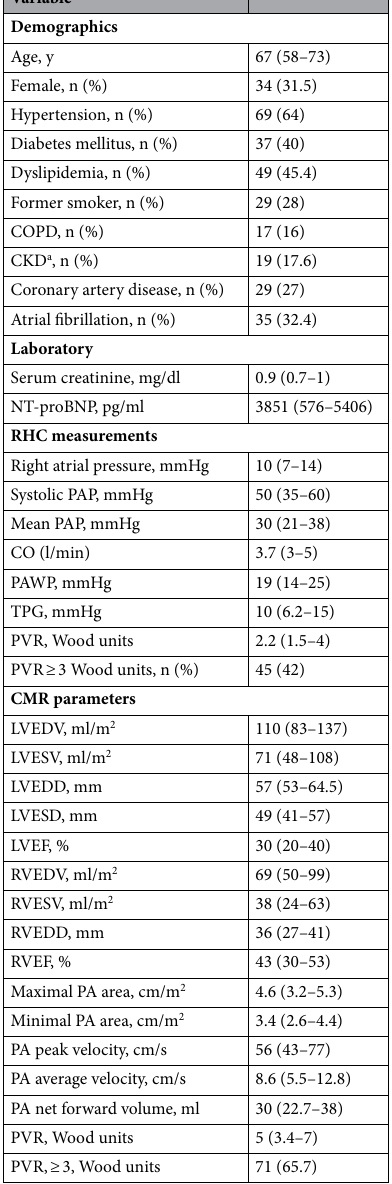
Table 1. Clinical, right heart catheterization and cardiovascular magnetic resonance variables. Data are given as n (%), or median (interquartile range). CMR cardiovascular magnetic resonance, CKD chronic kidney disease, CO cardiac output, COPD chronic obstructive pulmonary disease, LVEDD left ventricular end- diastolic diameter, LVEDV left ventricular end-diastolic volume, LVEF left ventricular ejection fraction, LVESD left ventricular end-systolic diameter, LVESV left ventricular end-systolic volume, NT-proBNP N-terminal pro- B-type natriuretic peptide, PA pulmonary artery, PAWP pulmonary arterial wedge pressure, PAP pulmonary artery pressure, PVR pulmonary vascular resistance, RHC right heart catheterization, RVEDD right ventricular end-diastolic diameter, RVEDV right ventricular end-diastolic volume, RVEF right ventricular ejection fraction, RVESV right ventricular end-systolic volume, RVP right ventricular pressure, TPG transpulmonary gradient. a Estimated glomerular filtration rate < 60 ml/min/1.73 m 2 by Cockcroft–Gault